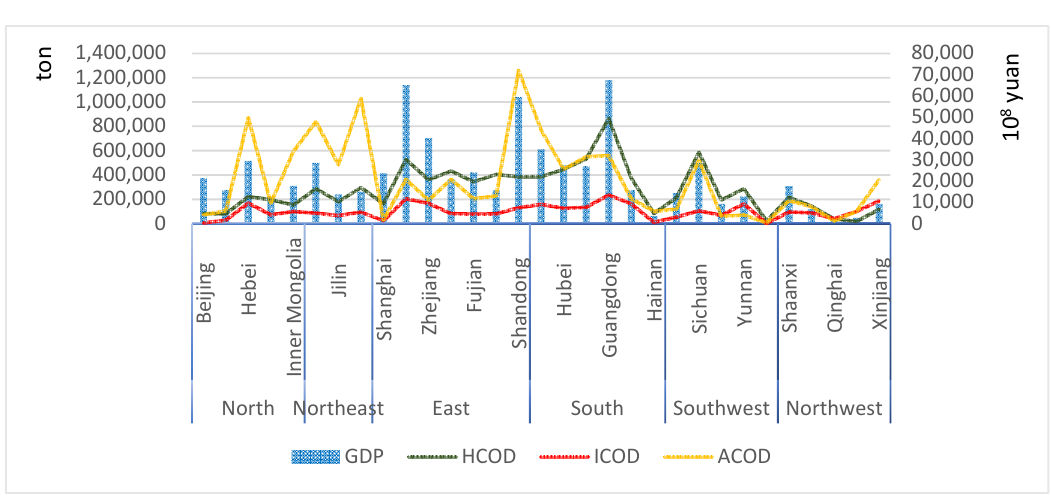
Figure 2. Output of water consumption.